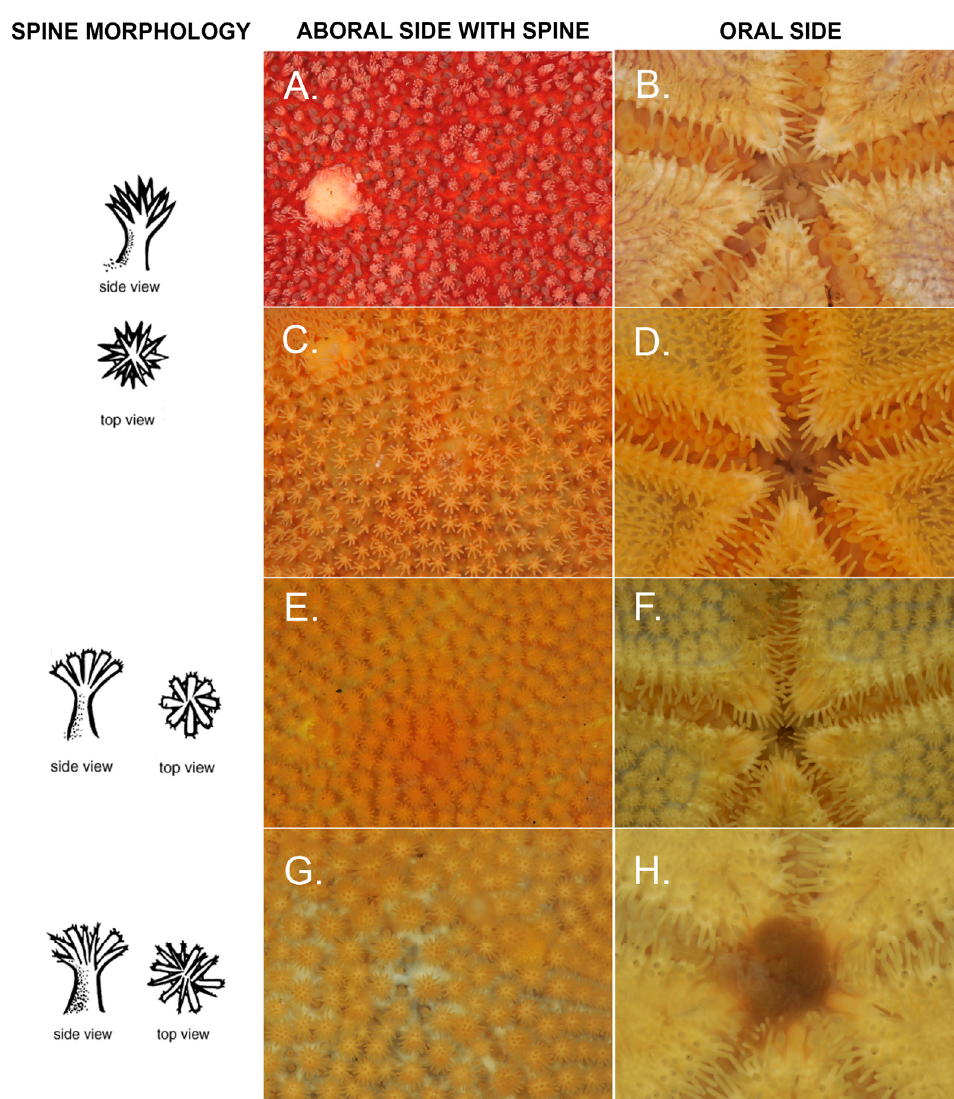
Figure 6. Photographic details of aboral side with spine on paxillae and oral close up, respectively: ( A , B ) O. validus red morphotype; ( C , D ) O. validus orange morphotype; ( E , F ) O. roseus ; ( G , H ) O. pearsei . Drawings of peculiar spine morphology for each species from Janosik & Halanych [34].